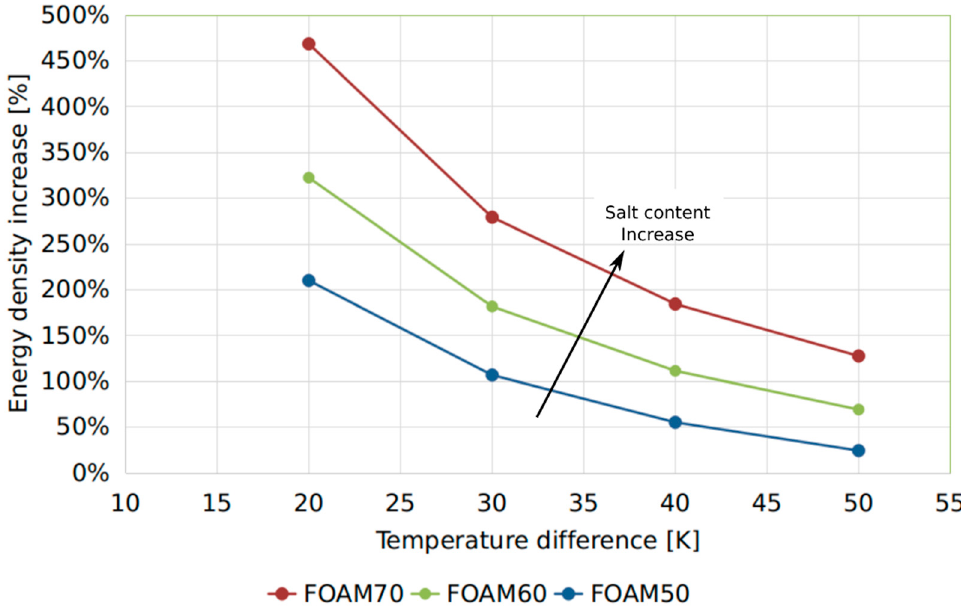
Figure 6. Energy density increase of the foamed samples against the sensible water for different temperature differences under which the sensible storage operates.